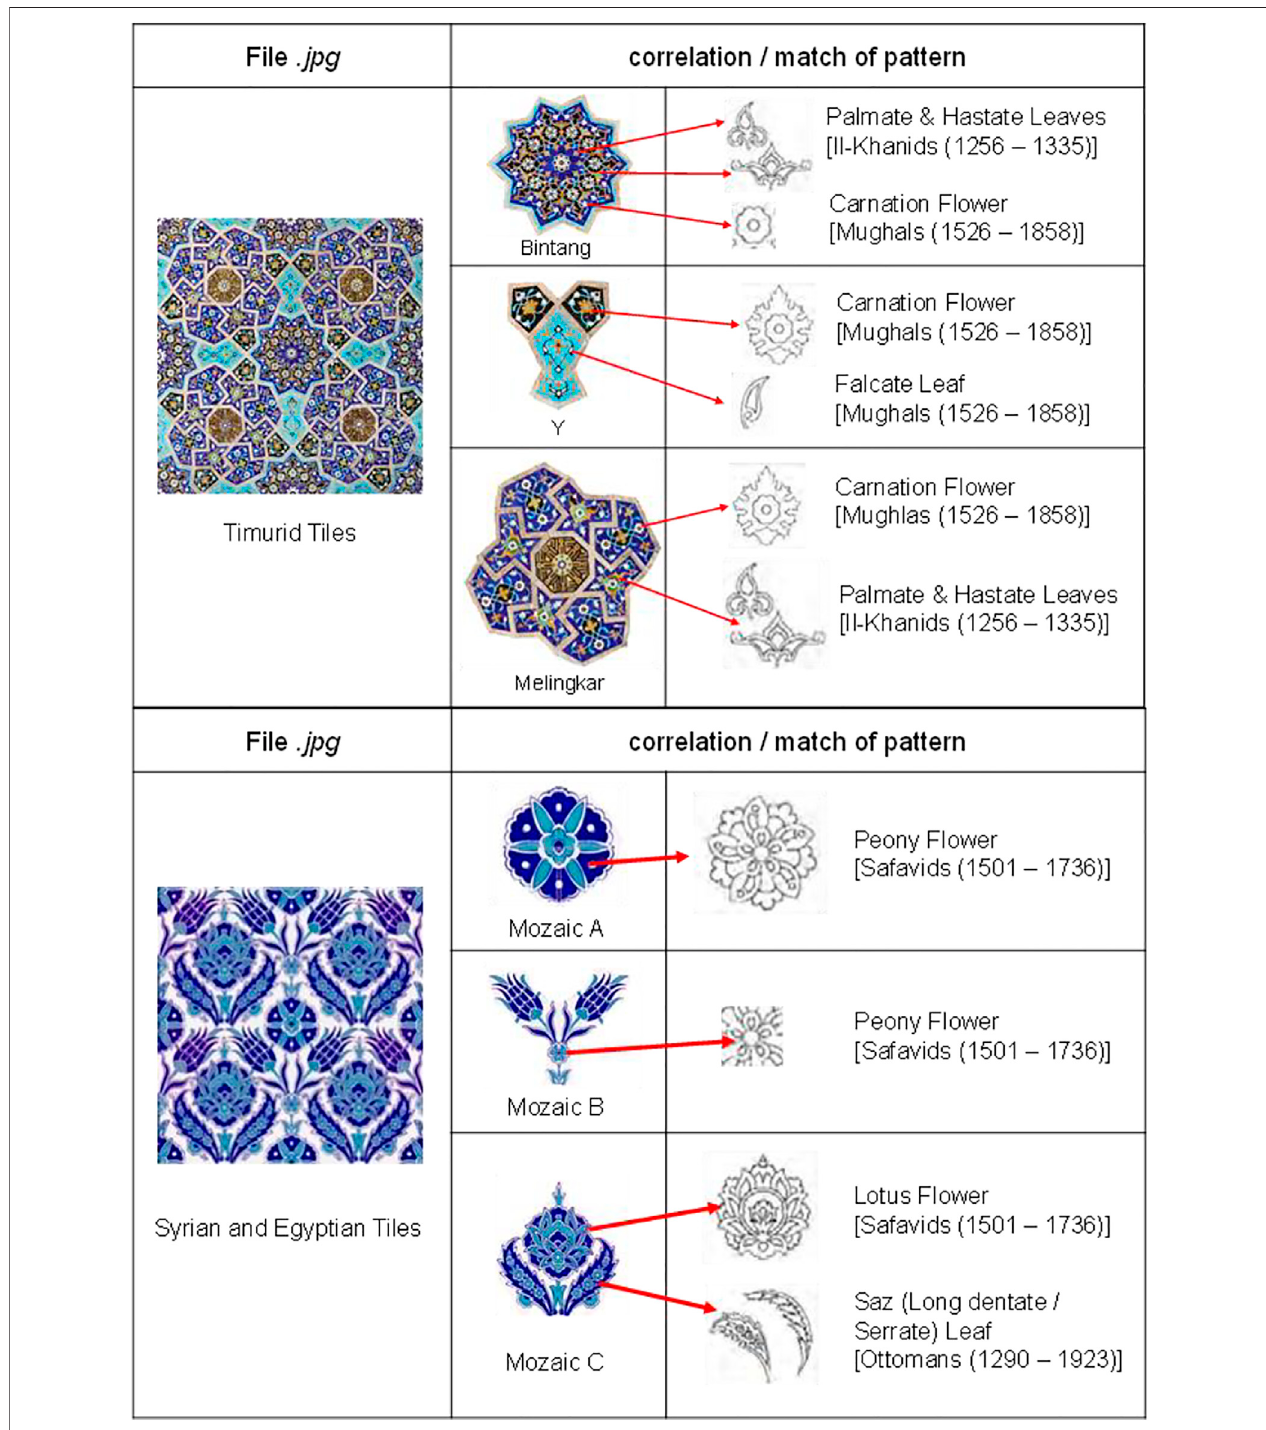
FIGURE 9 | (Last Table 4 ) Similarities between the customer images and main elements of Islamic fl oral ornamentation.